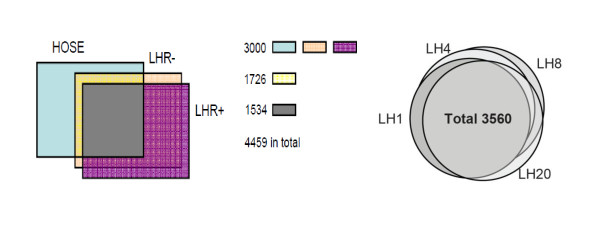
Venn diagram of the top 3,000 differentially expressed genes from HOSE cells, mock-transfected SKOV-3 cells (LHR-), and LHR+ cells (LHR) (left), and temporal effects after addition of LH to the LHR+ cells (right), respectively.